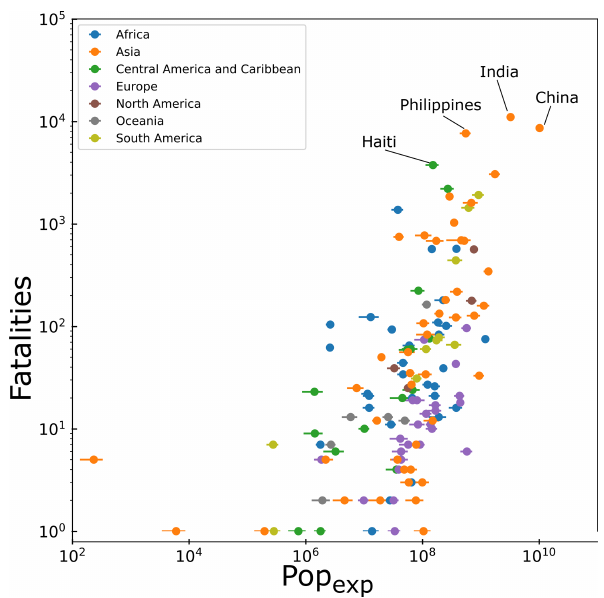
Figure 5. Showing the exposure of population (in units of total days exposed to nowcasts multiplied by population per year) against the number of total fatalities recorded in the dataset of Froude and Pet- ley (2018).